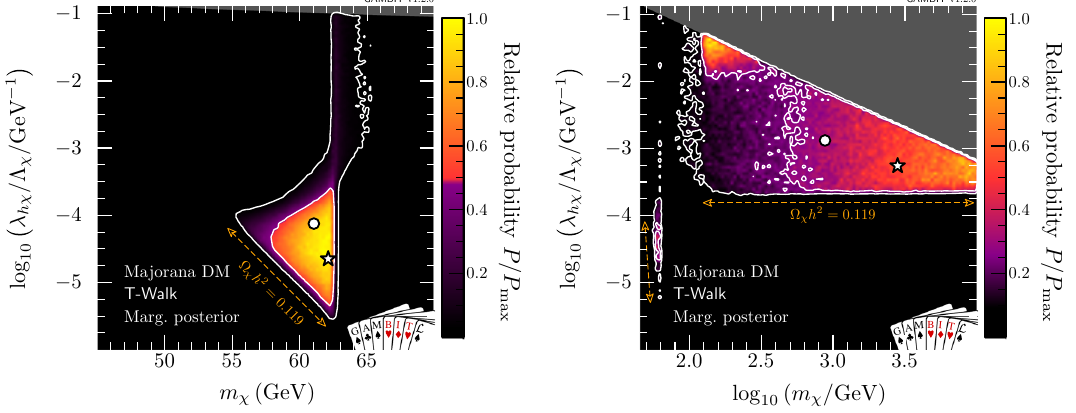
Fig. 8 Marginalisedposteriordistributionsinthe ( m χ ,λ h χ /Λ χ ) plane for Majorana fermion DM. Contour lines show the 1 and 2 σ credible regions. The left panel gives the result of a scan restricted to the reso- nance region around m χ ∼ m h / 2. The right panel shows a full-range parameter scan. The greyed out region shows where our approximate